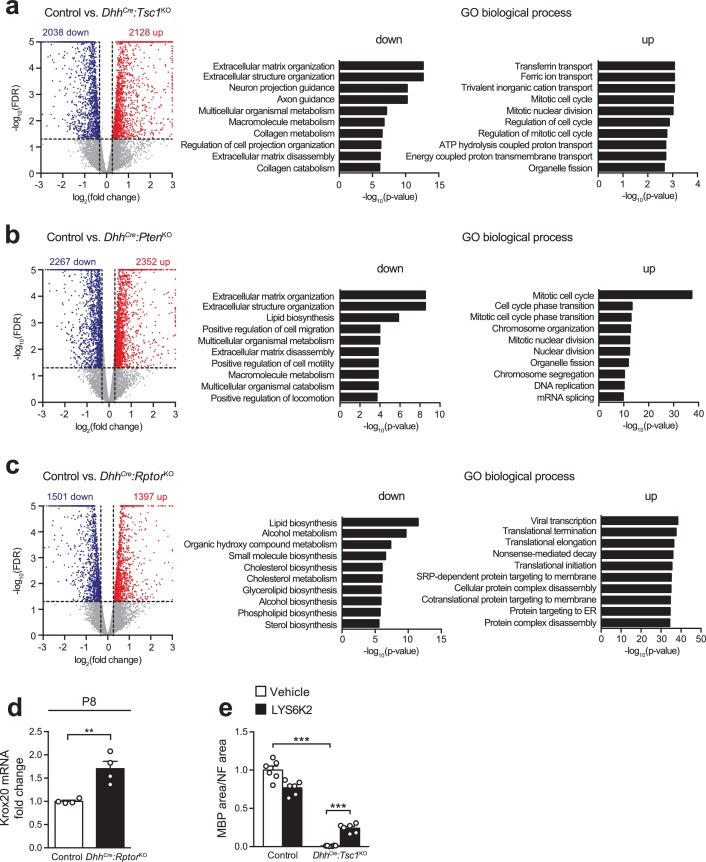
Transcriptome profile of P5 sciatic nerves in various conditions of mTORC1 activation.(a–c) Volcano plots (left) and gene-ontology analysis (right) of significantly (fold change >1.2, FDR < 0.05) upregulated (red) and downregulated (blue) genes in DhhCre:Tsc1KO, DhhCre:PtenKO, and DhhCre:RptorKO compared to control nerves at P5. (d) qRT-PCR from P8 control and DhhCre:RptorKO sciatic nerves. Transcript levels relative to control, after normalization toβ-actin. Bar height: mean; error bars: s.e.m. (n = 4 mice/genotype, two-tailed unpaired Student’s t-test, t(6) = 4.401, p=0.0046). (e) Quantification referring to Figure 3l. Data are expressed as average ratio between the MBP-positive area and the corresponding NF-positive area. The vehicle-treated control average is set to 1. Bar height: mean; error bars: s.e.m. (n = 6 coverslips/condition, two-way ANOVA with Dunnett’s multiple comparisons test, F(1,20) = 45.18, p<0.0001; pvehicle control vs TSC1KO = 0.0001, pTSC1KO vehicle vs LYS6K2 = 0.0004). **p<0.01, ***p<0.001.